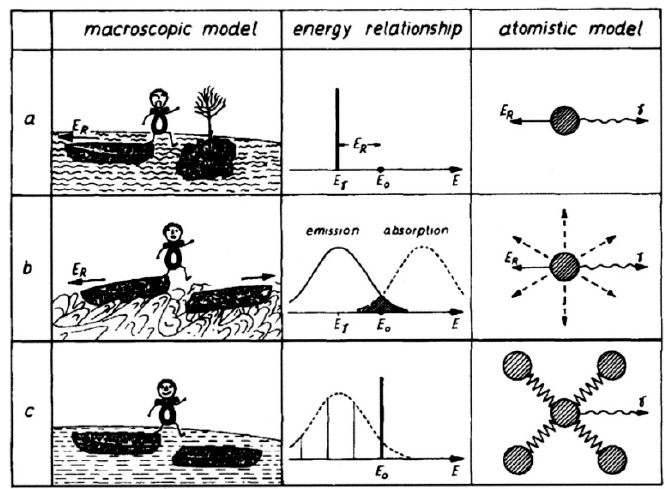
Figure 4. In ( a ), Mr. Gamma attempts to jump from the boat to the island, but fails because some of the jump energy is lost by recoil. In ( b ), the swell, which is the effect of thermal agitation, widens the emission and absorption lines that partially overlap, with some probability that the jump will succeed. In ( c ), the pond is frozen and the jump happens successfully in the absence of recoil. In ( a ) and ( b ), the atom is free, while in ( c ), it is constrained into a crystalline lattice, a situation that can be represented with a system of springs. Reproduced from [10].